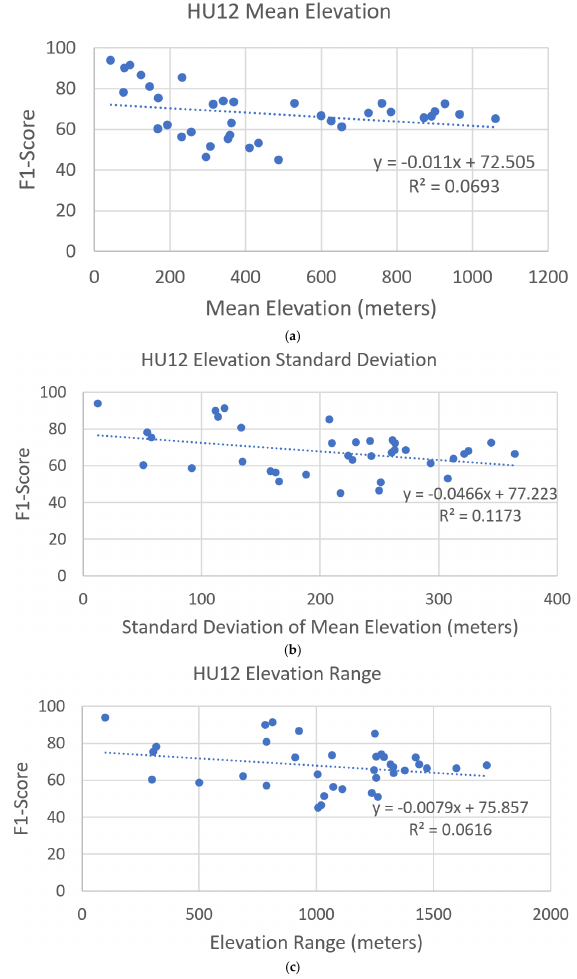
Figure 13. Plot of linear relations between ( a ) mean, ( b ) standard deviation, and ( c ) range in elevation for HU12 watersheds and F1-scores determined for 36 test HU12 watersheds. Hydro features are predicted from the U-net model 14 trained with 14 HU12